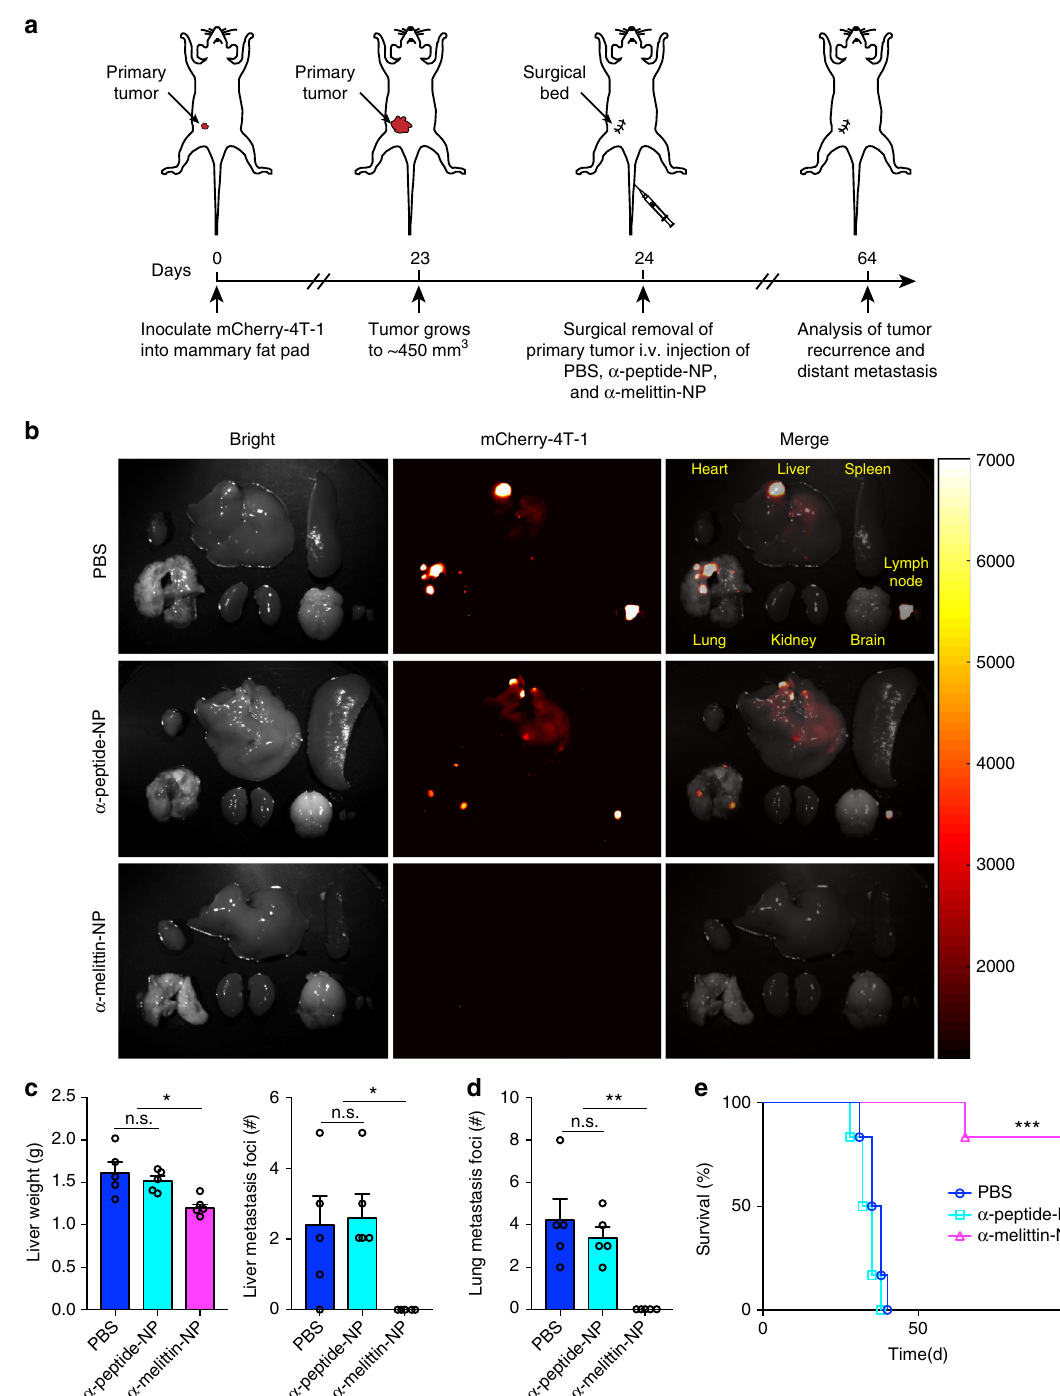
Fig. 5 Effect of α -melittin-NPs in a spontaneous metastatic tumor model. a Schematic illustration of α -melittin-NP therapy in a mouse model of spontaneous liver metastasis. The mCherry-4T-1 cells (3 × 10 5 ) were inoculated into the mammary fat pads of syngeneic BALB/c mice and the primary tumors were resected when they reached about 450 mm 3 in volume following treatment with PBS, α -peptide-NPs or α -melittin-NPs on days 0, 7, and 14, respectively, post surgery. The numbers of metastatic lesions in different organs were quanti fi ed by whole-body fl uorescence system. b Representative images of organ tumor burdens on day 64. c Quanti fi cation of the liver weights (left panel) and liver metastatic foci (right panel) of mice sacri fi ced on day 64 ( n = 5 mice per group). d Quanti fi cation of the lung metastatic foci of mice sacri fi ced on day 64 ( n = 5 mice per group). e Mouse survival was monitored over the course of 100 days post surgery ( n = 6 mice per group). Error bars indicate SEM. n.s. not signi fi cant; *** P < 0.001; ** P < 0.01; * P < 0.05; by one-way ANOVA followed by Bonferroni ’ s post hoc test c , d or by log-rank Mantel-Cox test